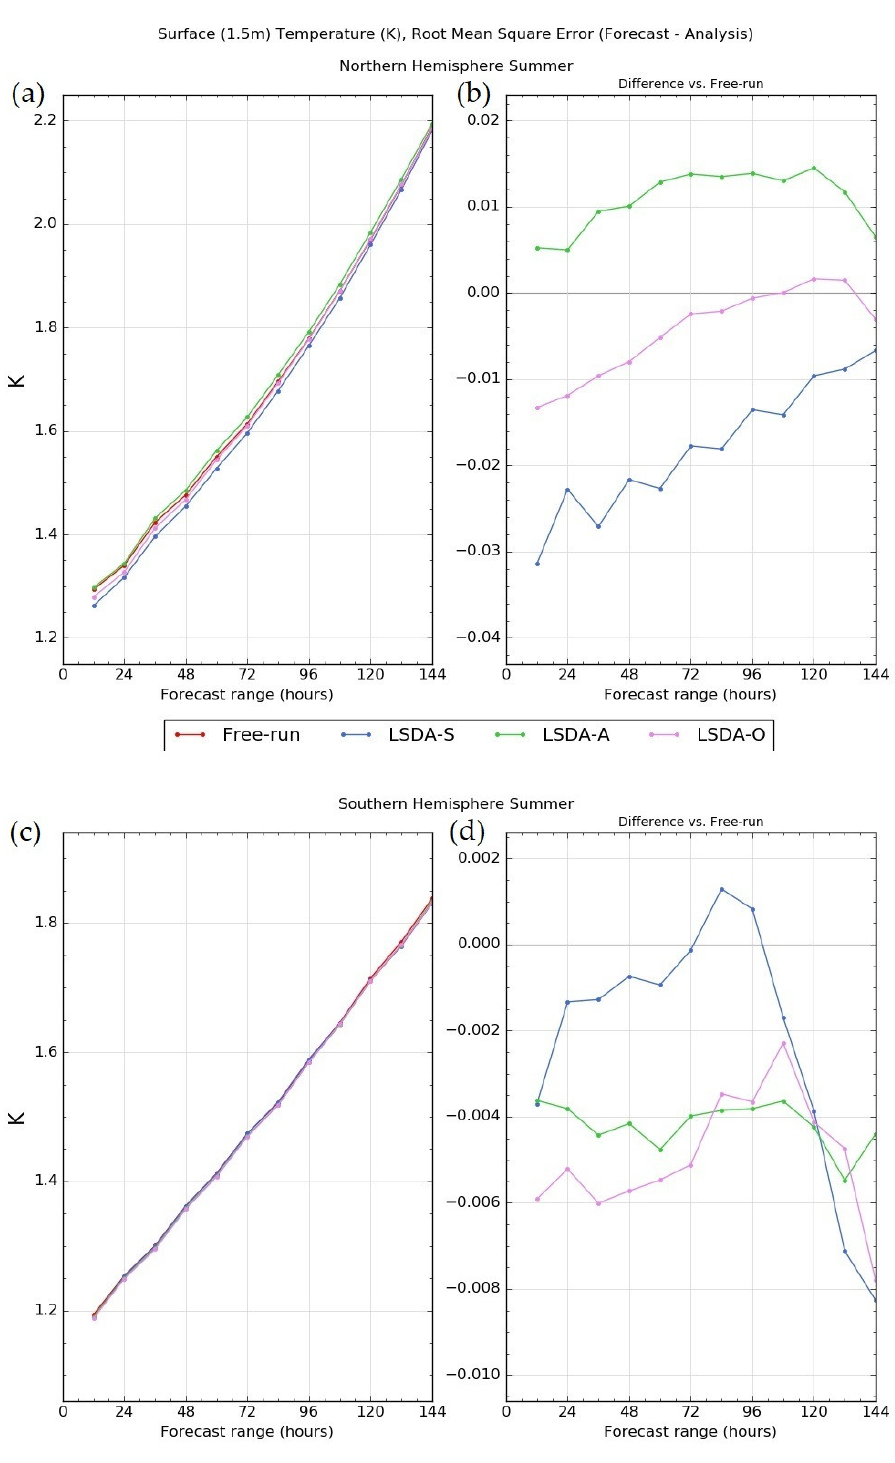
Figure 5. As in Figure 4, but for the summer period of 15 July, 2018 to 15 October, 2018 (92 days) for the Northern hemisphere (panels a , b ) and 1 December, 2017 to 19 February, 2018 (81 days) for the Southern hemisphere (panels c , d ).